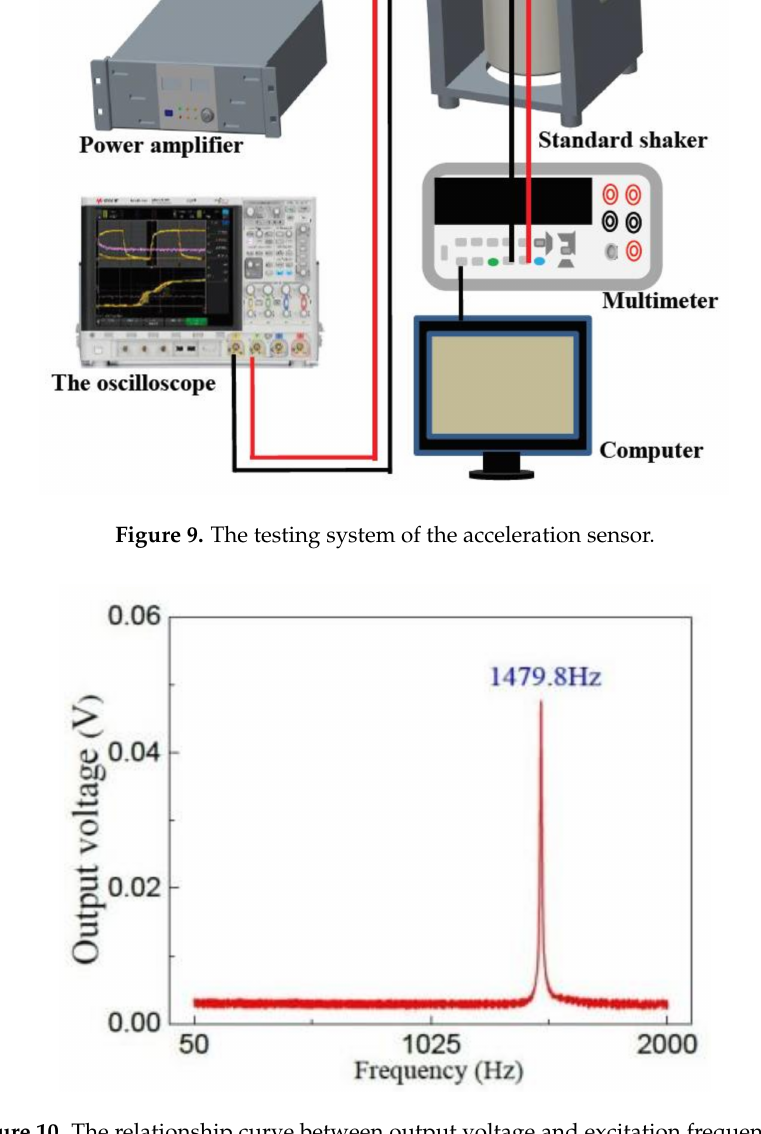
Figure 10. The relationship curve between output voltage and excitation